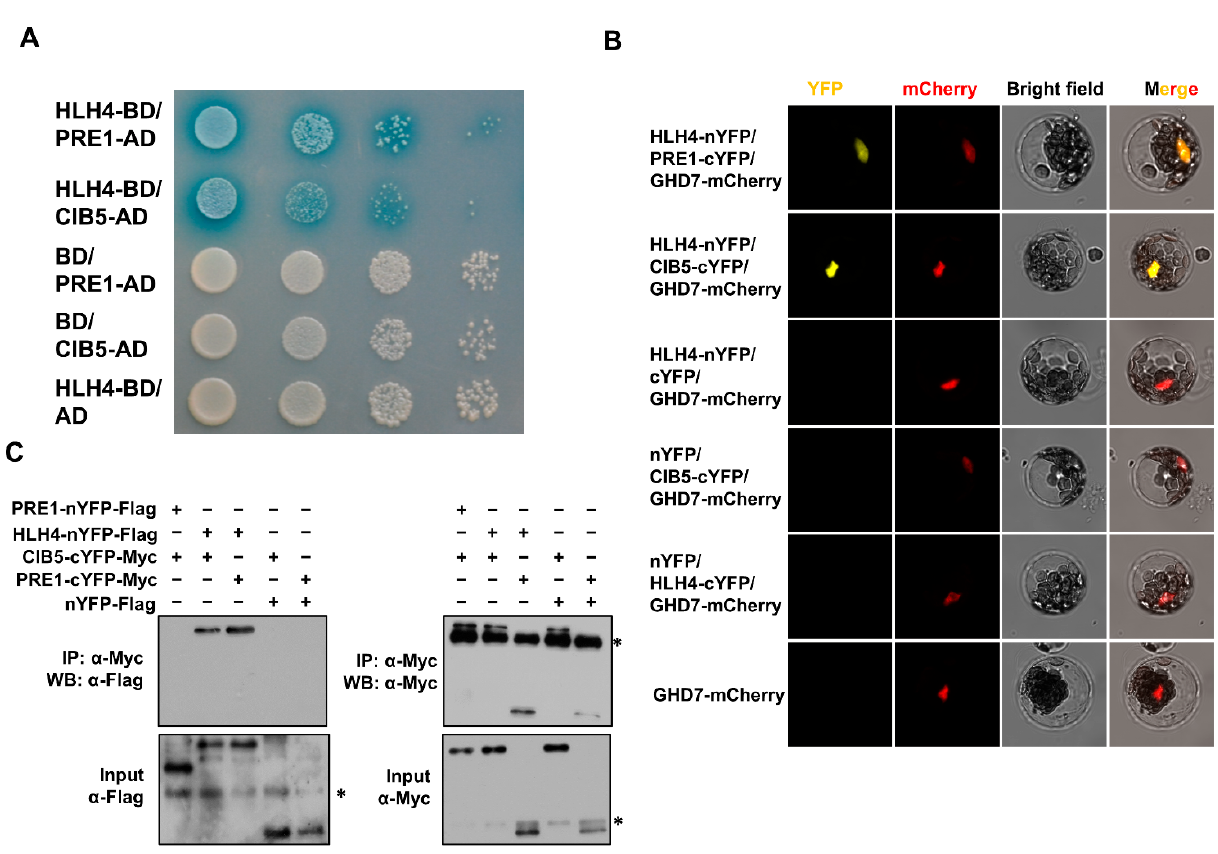
Figure 5. HLH4 interacts with CIB1 and PRE1. Yeast two hybrid ( A ), BiFC ( B ) and protoplast co-immunoprecipitation (Co-IP) ( C ) assays indicate that HLH4 interacts with CIB1 and PRE1. The GHD7-mCherry plasmid was used as a nuclear marker. Asterisk * in ( C ) represents unspecific protein bands.